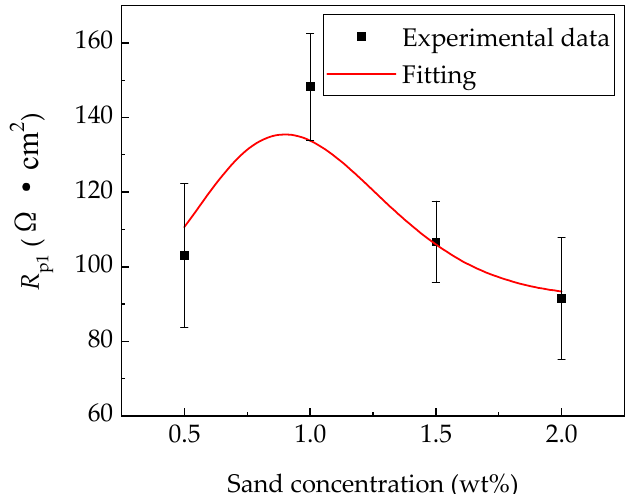
Figure 6. EIS diagram measured on 20 # steel in oil-water flow under different sand concentrations.